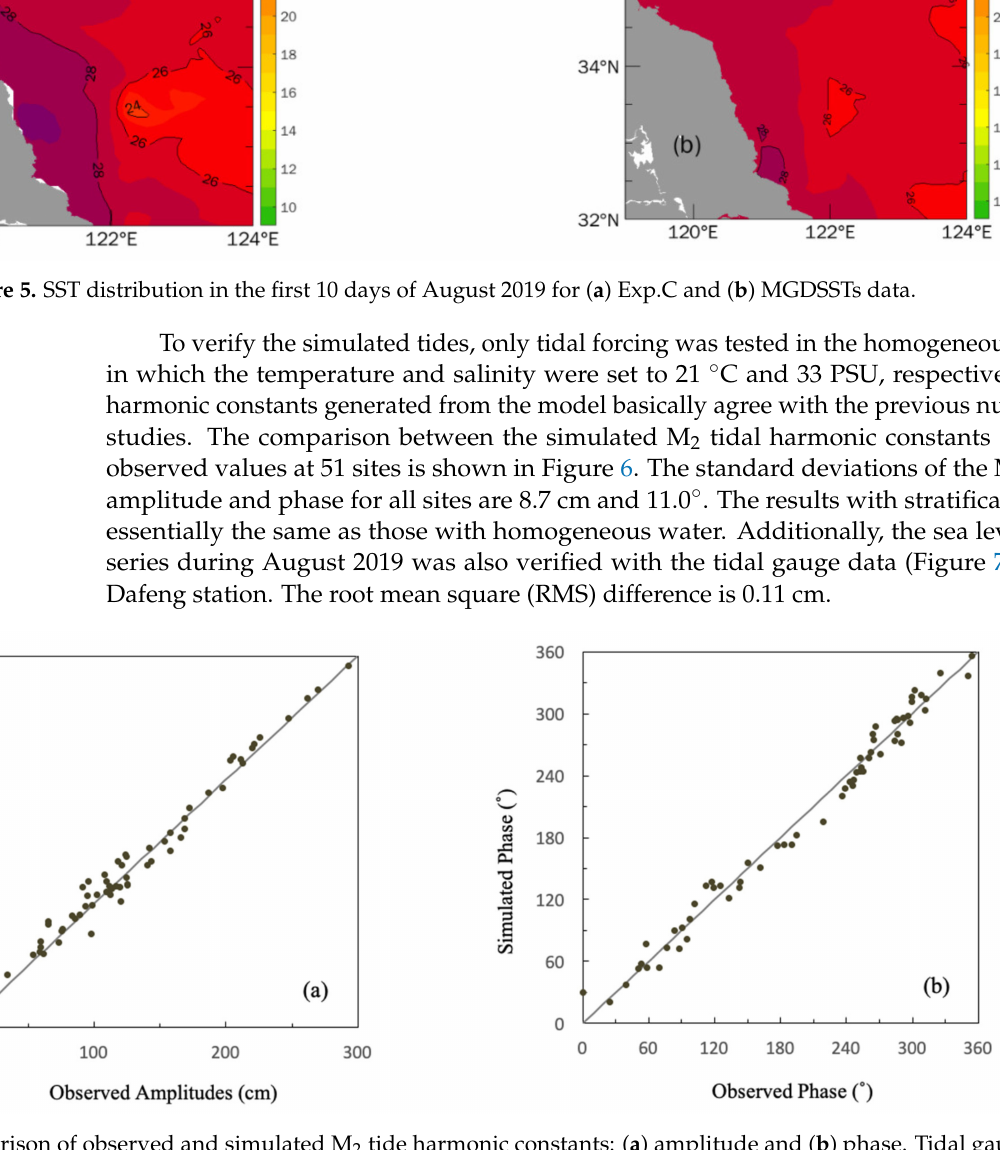
Figure 6. Comparison of observed and simulated M 2 tide harmonic constants: ( a ) amplitude and ( b ) phase. Tidal gauge stations are shown as red dots in Figure